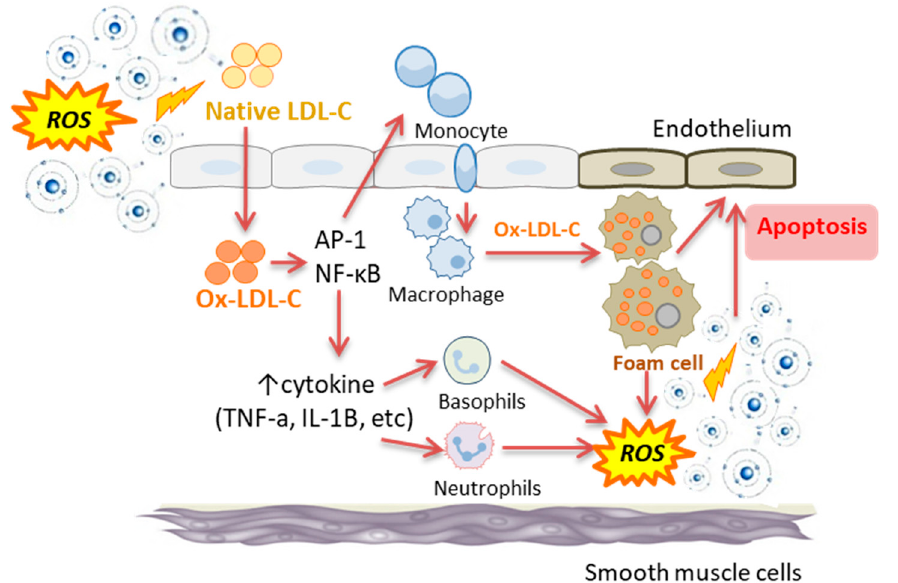
Figure 1. The interplay between oxidative stress and inflammatory processes (i.e., NF κ B and cytokine activity) in the development of endothelial cell damage and apoptosis. ROS: reactive oxygen species; Ox-LDL-C: oxidised low density lipoprotein cholesterol; AP-1: activator protein-1; NF- κ B: nuclear factor-kappa B; TNF- α : tumour necrosis factor- α ; IL-1 β : interleukin-1 β . In this context, studies in otherwise healthy individuals have shown F2-isoprostanes, malondialdehyde (MDA), 8- hydroxy deoxyguanosine (8-OHdG), oxidised disulphide form of cystine (CySS), and the ratio of glutathione (GSH) to its oxidised disulphide form (GSSG), and subclinical